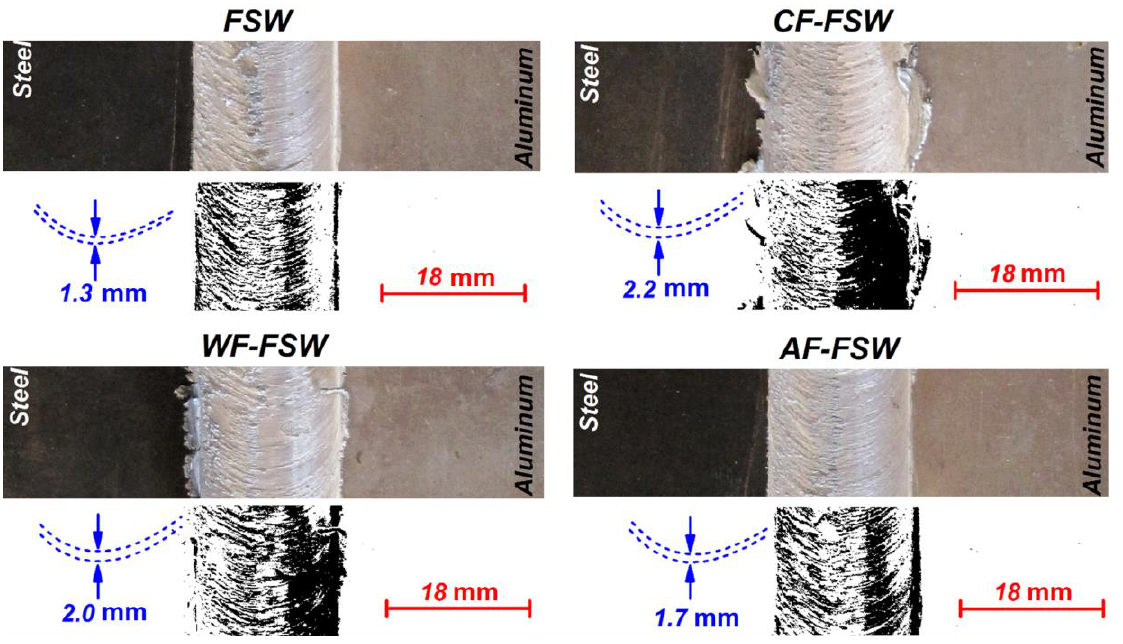
Figure 4. Surface analysis of various